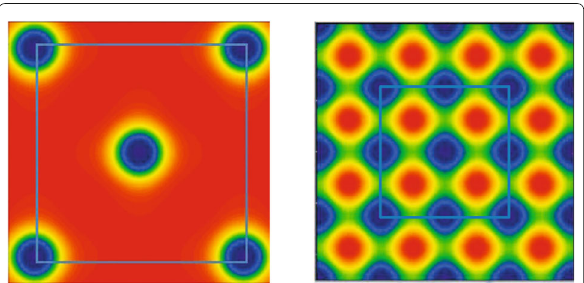
Fig. 1 Distribution of the baryon number density in the skyrmion (left panel) matter and half-skyrmion matter (right panel). From [37]